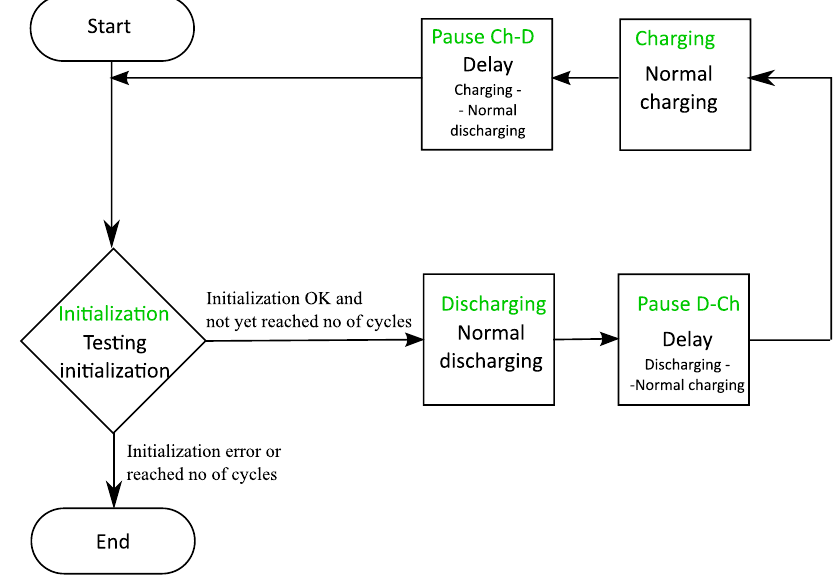
Figure 5. The basic state machine diagram used for measurement of one